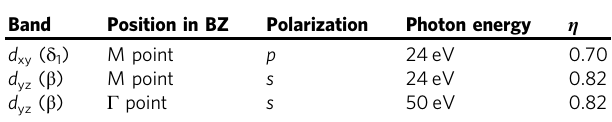
Table 1 Parameters for high-visibility replica bands in the fi rst